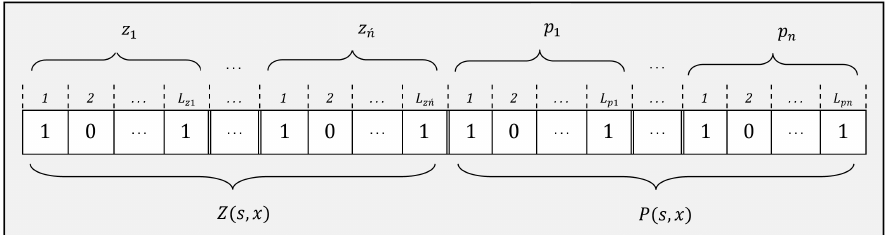
Figure 2. Encoding of a solution: If 𝑆 (cid:3036) = 1, the 𝑖 -th symbolic term is present in the solution; other- wise, if 𝑆 (cid:3036) = 0, the 𝑖 -th term has been discarded from the solution. if S i = 0, the i -th term has been discarded from the